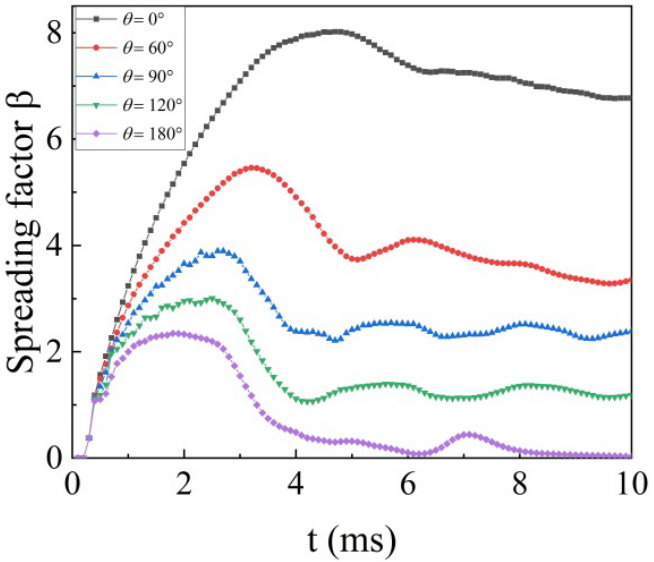
Figure 8. Time evolution of droplet spreading factors with different surface contact angles ( V = 1 m/s, T s = 500 K, D 0 = 1 mm).